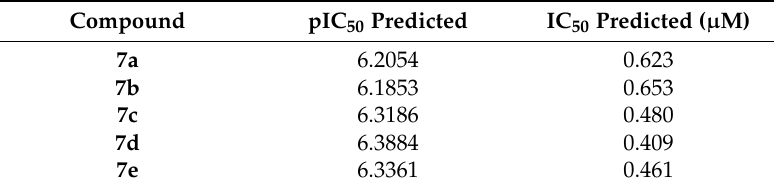
Table 3. Predicted cytotoxic activity for the newly designed structures using the comparative molecular field analysis (CoMFA)